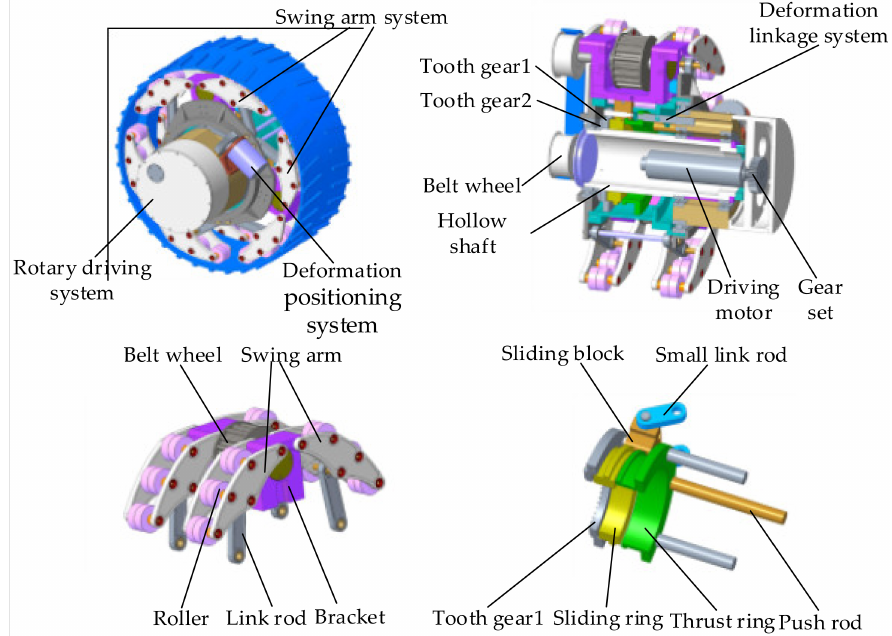
Figure 1. Structural diagram of the reconfigurable wheel-crawler